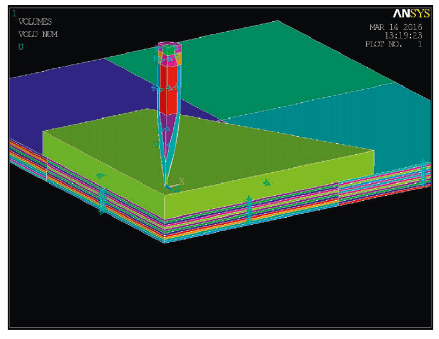
Figure 5: Target plate Table 4: Mechanical properties of SiC.